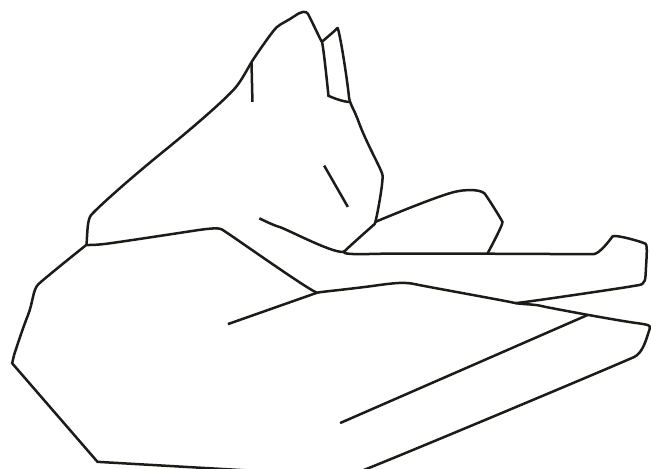
Figure 7: Drawing made by abstracting 38 points of maximum curvature from the contours of a sleeping cat and connecting these points appropriately with a straight edge. Reproduced from Figure 3 in [27], with